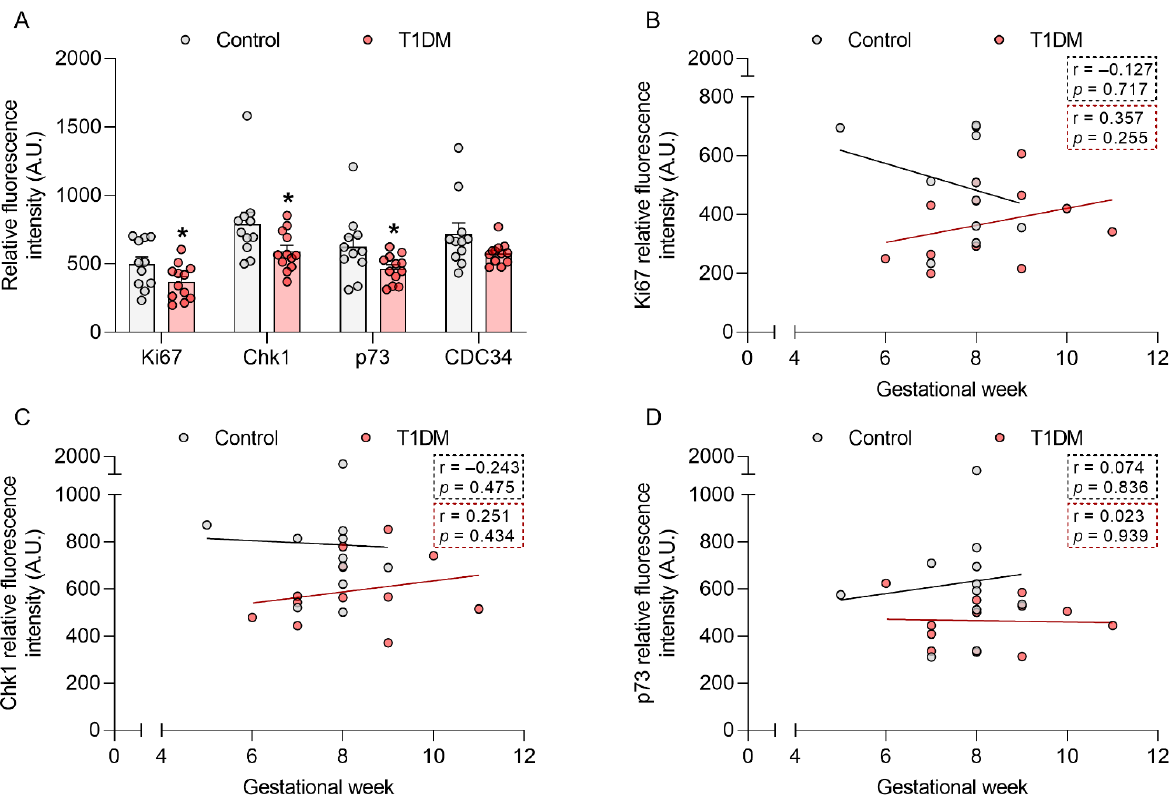
Figure 1. Type-1 diabetes mellitus (T1DM) downregulates Ki67, chk1, and p73 protein levels in early pregnancy. The level of 60 proteins involved in cell cycle regulation and cell proliferation was assessed in human first trimester placental tissue from healthy pregnancies (control, n = 11, gestational week (GW) 5–9) and those complicated with T1DM ( n = 12, GW 6–11) using a protein array ( A ). Associations between GW and Ki67 ( B ), chk1 ( C ), and p73 ( D ) levels were also calculated. vs. control.